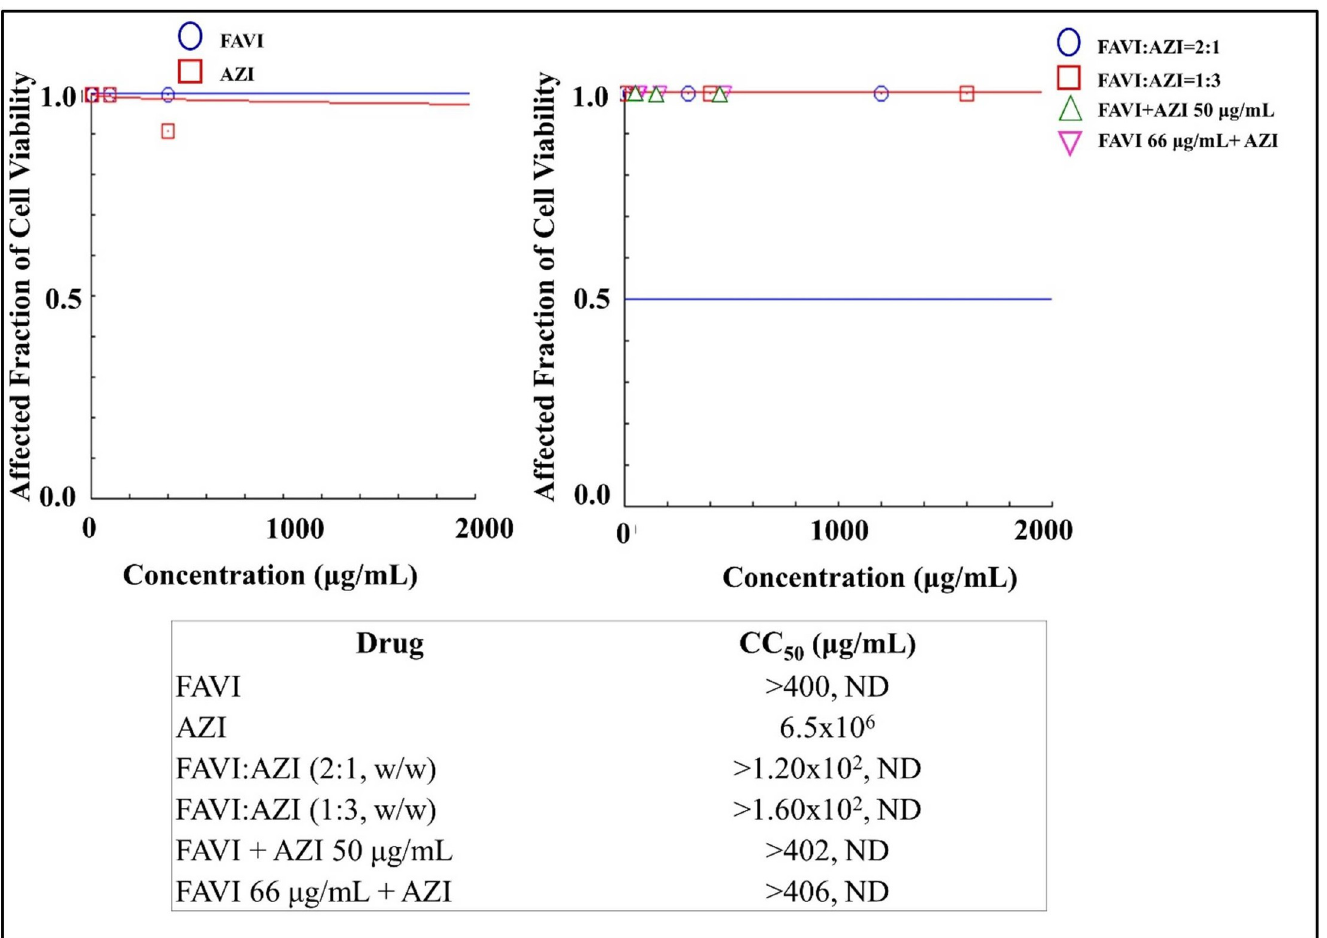
Fig 9. The cytotoxicities of Favipiravir (FAVI) and Azithromycin (AZI) as a single drug (left) and dual drug combination in constant and non-constant ratios (right) analysed by using CompuSyn Software (n = 3). At non-constant ratios of FAVI + AZI 50 μ g/mL, AZI was added at a concentration of 50 μ g/mL to each increased levels of FAVI i.e. 0.2, 2, 10, 100, and 400 μ g/mL. On the other hand, FAVI was then added at a concentration of 66 μ g/mL to each increased levels of AZI i.e. 0.2, 2, 10, 100, and 400 μ g/mL to produce FAVI 66 μ g/mL + AZI.